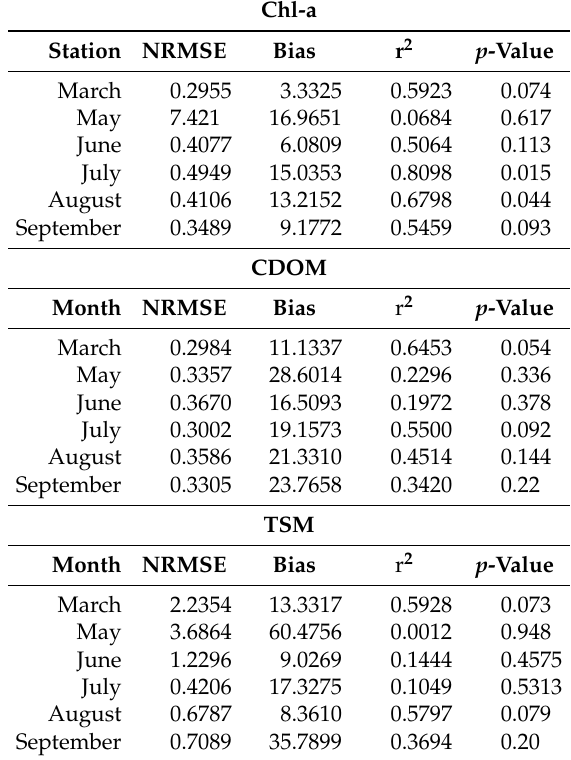
Table 5. Validation results: summary of the computed measures for the water quality parameters for each